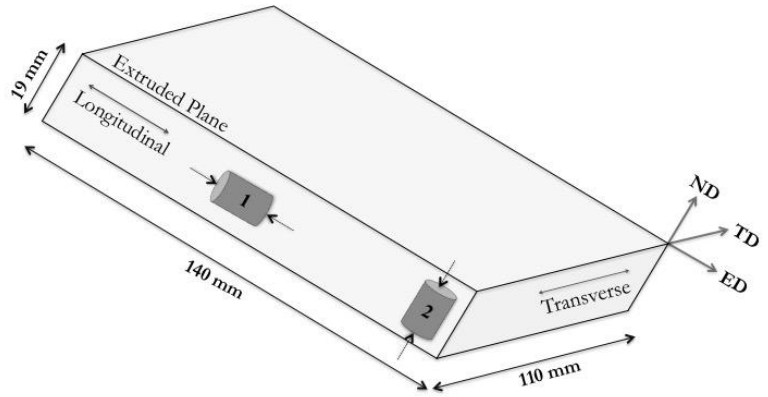
Figure 1. Schematic of the as-received extruded ZK60A-T5 plate (dimensions not to scale are provided) with the specimen orientations for compression testing: ( 1 ) for loading along extrusion direction (ED) and ( 2 ) for loading along the normal direction (ND).